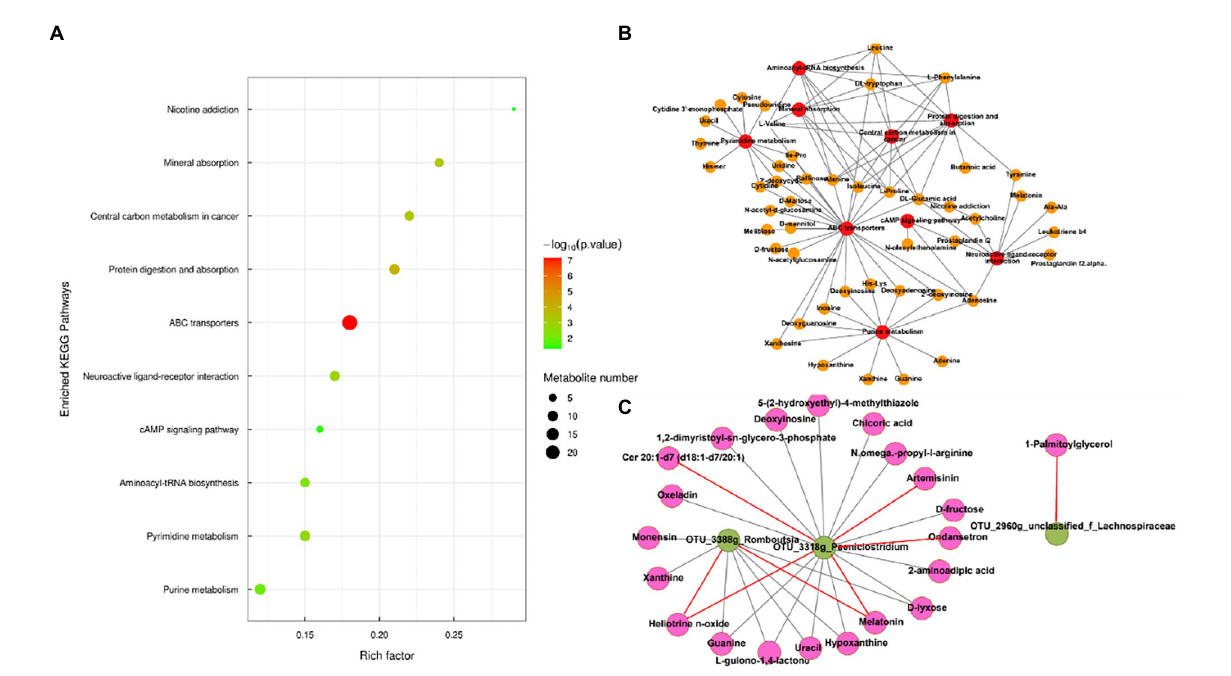
FIGURE 4 (A) Enriched Kyoto Encyclopedia of Genes and Genomes pathways of the comparison between the low-altitude (LA) and high-altitude (HA) groups (only those with a p < 0.05 are shown). (B) Network of enriched pathways and the differential metabolites between the LA and HA groups. (C) Correlation between gut core OTU (relative abundance > 0.1%) and differential metabolites in enrichment pathways based on (A) in the network (only those with | r | > 0.80, p < 0.05 are shown). Red and brown lines indicate positive and negative correlations,